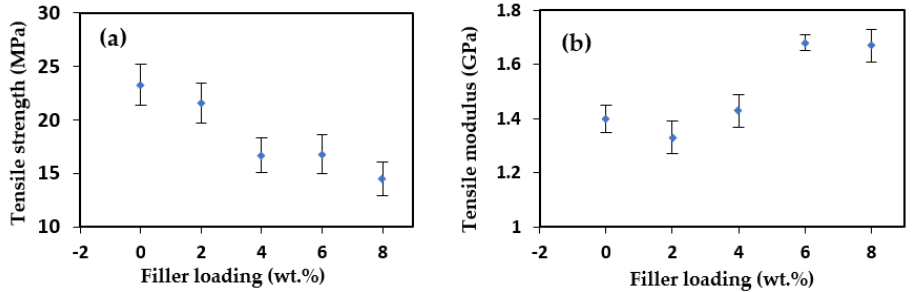
Figure 4. Effect of filler loading on the fused filaments: ( a ) Tensile strength; and ( b ) Tensile modulus.